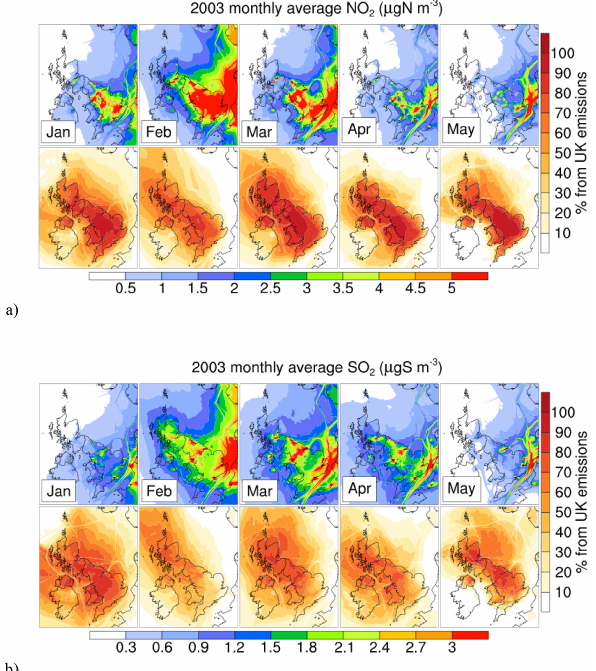
Figure 7. Modelled monthly average surface concentrations and UK contributions for (a) NO − and (b) SO 2 − from January to 3 4 May 2003. In each case the upper panel shows the mean con- centrations (µgNm − 3 or µgSm − 3 ), while the lower panel shows the percentage contribution from UK emissions (calculated as [100×(Base − no UK emi)/Base] between the base simulation and the simulation with zero UK emissions).